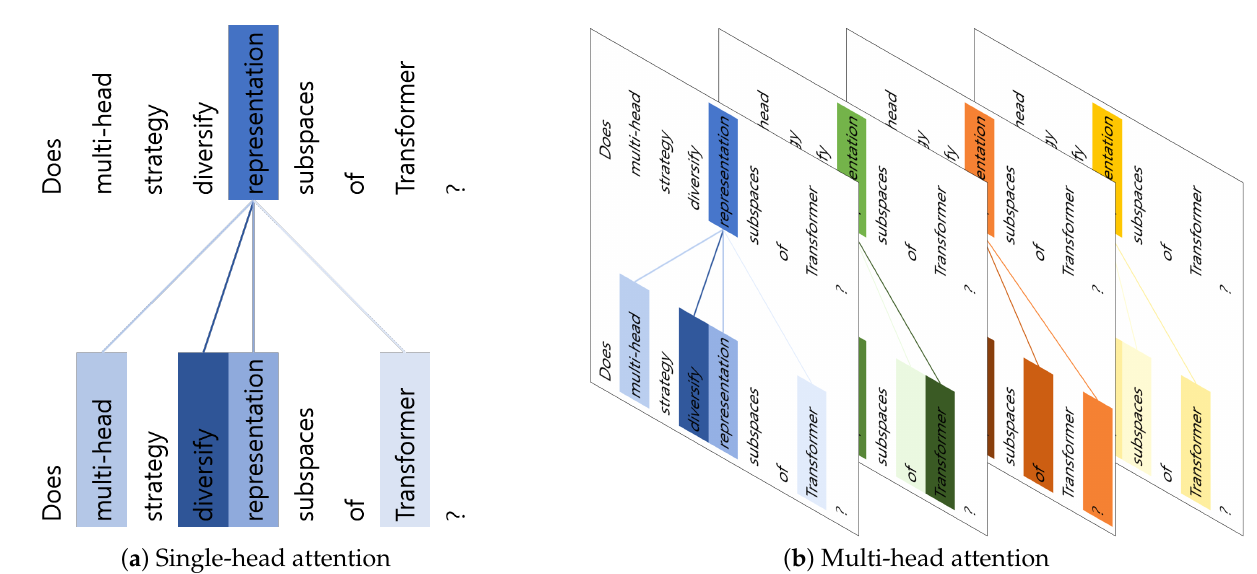
Figure 1. Visualization of attention weights in single-head attention and multi-head attention. Each head in multi-head attention assigns different weights to each